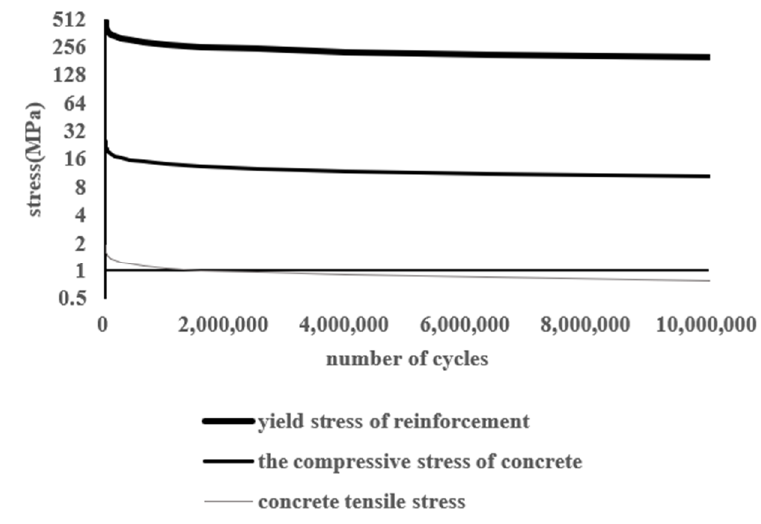
Figure 6. The S–N curve of reinforcement and concrete.